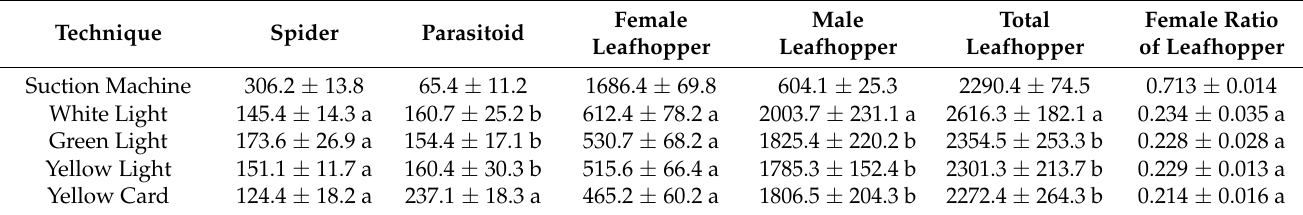
Table 1. Total number of Empoasca onukii and predators and mean female ratio of tea green leafhopper collected during the course of the field experiment.